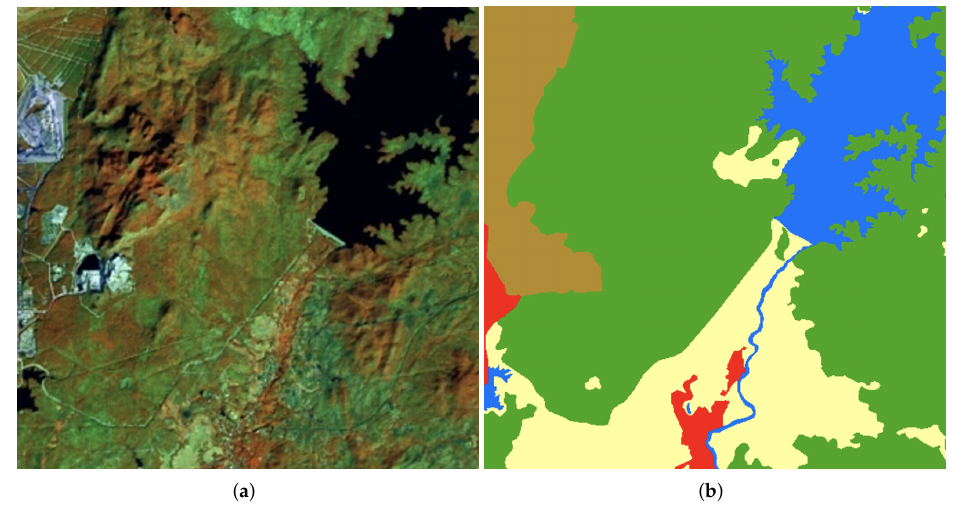
Figure 1. The sample of input image ( a ) and the target label ( b ) from the Landsat-8